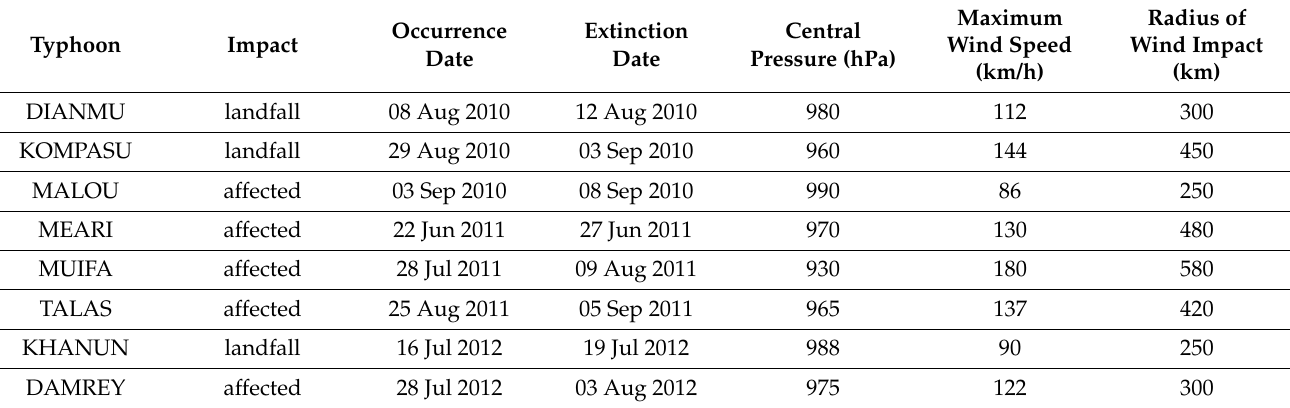
Table 1. List of affecting and landfalling typhoons from 2010 to 2019, provided by Korea Meteorologi- cal Administration (KMA).